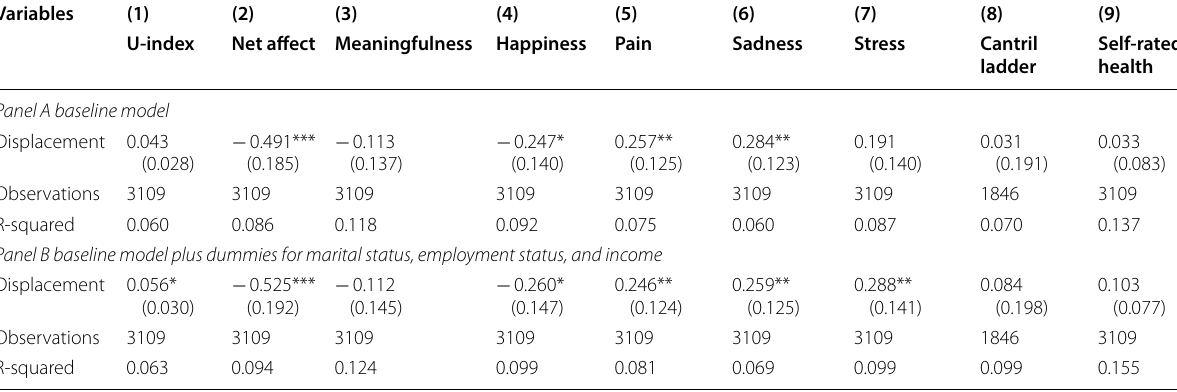
The estimates in columns 1 through 7 and 9 are OLS coefficients from the 2010, 2012, and 2013 ATUS WB Modules; the estimates in column 8 are OLS coefficients from the 2012 and 2013 ATUS WB Modules. All estimates use the WB Module final weight (WUFINLWGT). Standard errors in parentheses. *** p < 0.01, ** p < 0.05, * p < 0.1. The following control variables are included in all columns in both Panels A and B: age and its square; three dummies for race/ethnicity; five education dummies; number of disabilities; an immigrant dummy; number of children; a metropolitan status dummy; two season dummies; year dummies; dummies for the DWS year; and state dummies. Columns 1 through 7 additionally contain a holiday dummy and six dummies for the days of the week. Panel B additionally includes two marital-status dummies; two employment-status dummies; and four dummies for family income during the last 12 months